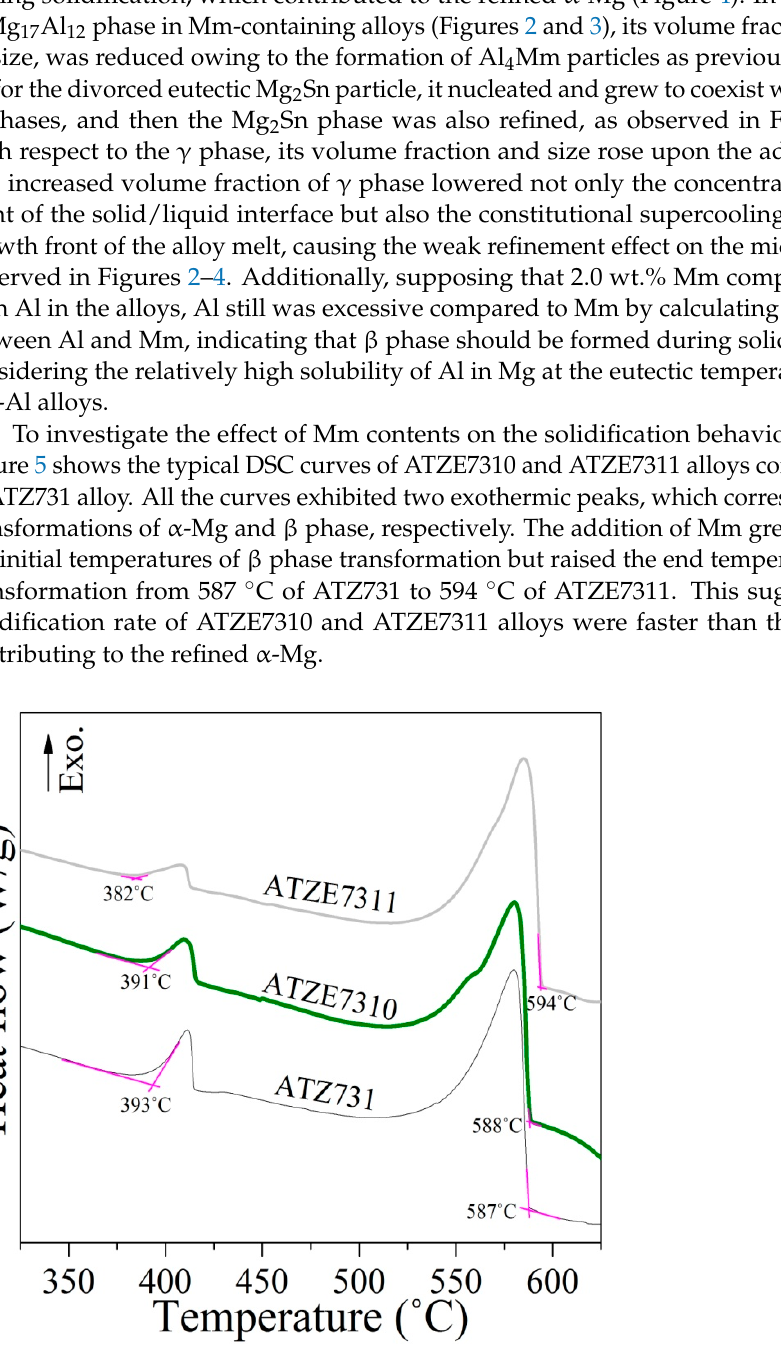
Figure 5. The typical DSC curves of as-cast samples for ATZ731, ATZE7310 and